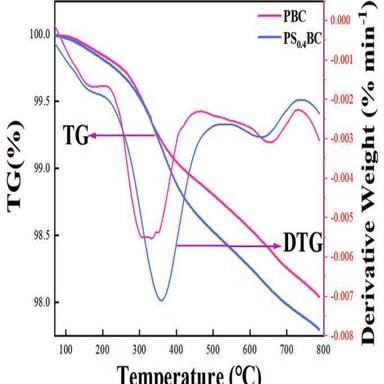
Thermogravimetric change curve of PBC and PS0.4BC at 30–800 ◦C.